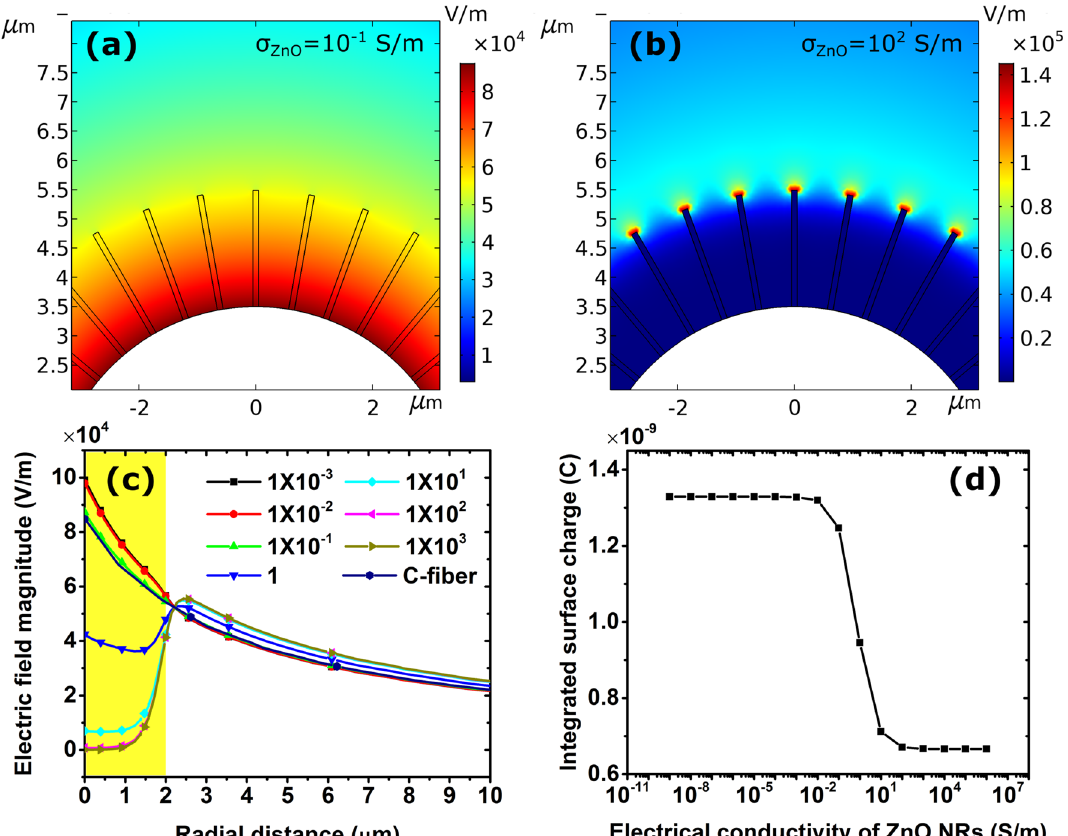
Figure 6. Distribution of the electric field magnitude for a C-fiber (white color) decorated with ZnO NRs with electrical conductivity of ( a ) 10 –1 S/m and ( b ) 10 2 S/m. ( c ) Radial profile of the electric field magnitude from the C-fiber surface to a distance of 10 µm for different electrical conductivity (S/m) of the ZnO NRs and for a bare C-fiber without NRs. The yellow area indicates the radial shell that contains the 2 µm long NRs. ( d ) Integrated surface charge on a C-fiber and NRs for different ZnO NR electrical conductivities. The potential of the C-fiber surface is set to 1 V relative to a zero-potential ground at infinity in all